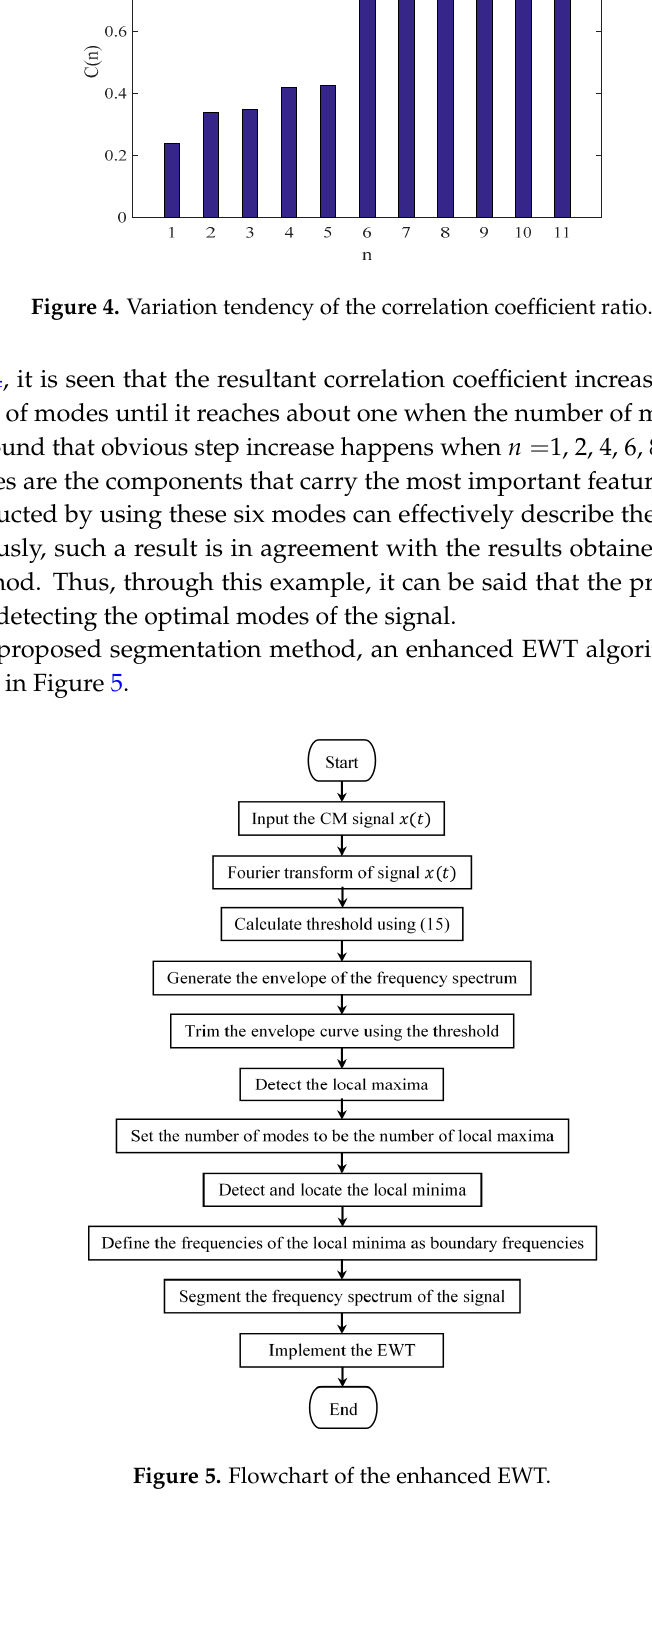
Figure 5. Flowchart of the enhanced EWT.